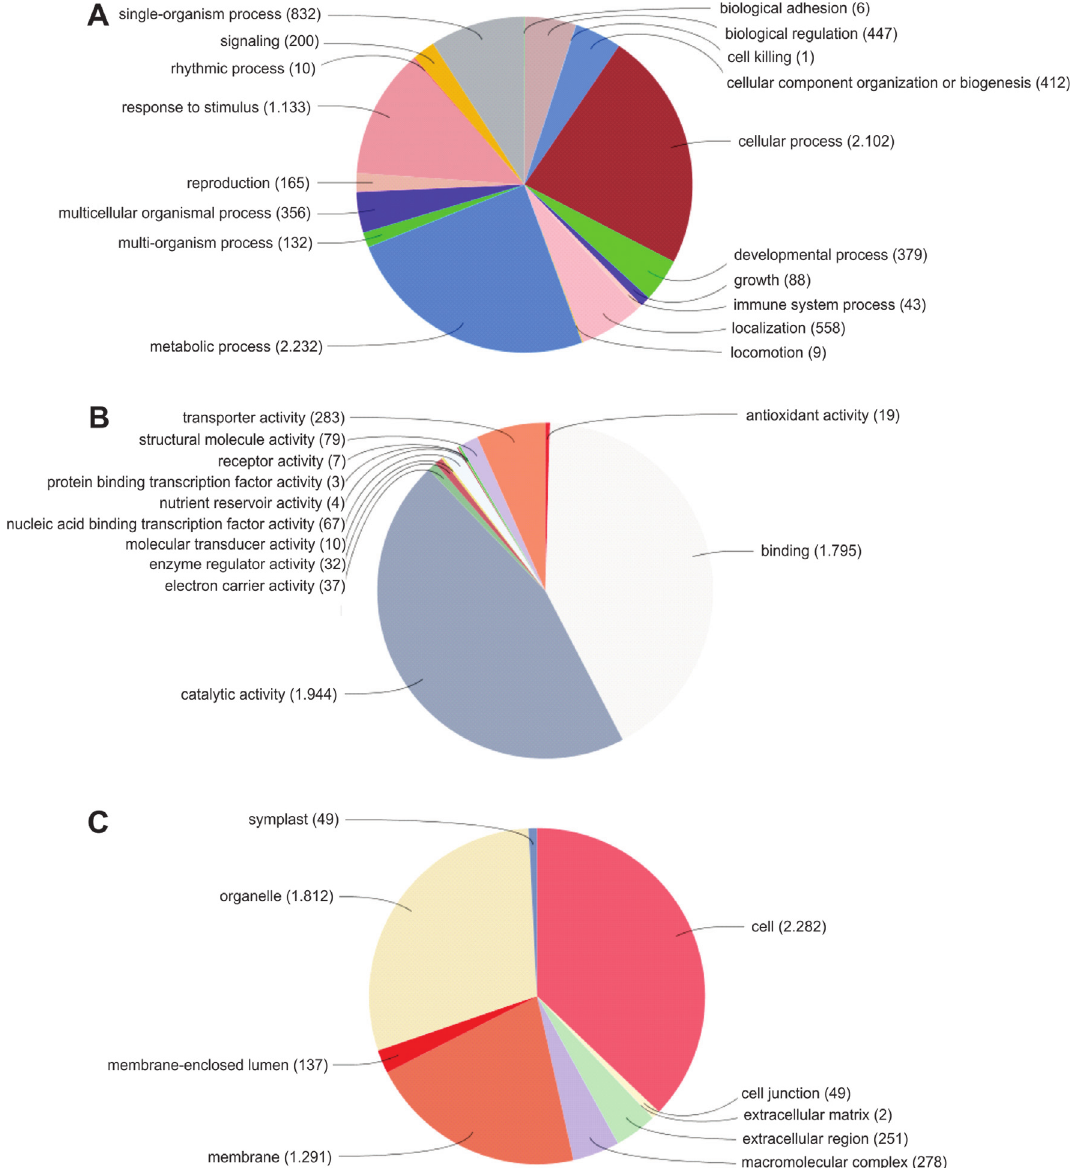
Figure 5 - Pie diagrams demonstrating the percentage of contigs and singlets generated in CAP3 within the functional categories of Gene Ontology. Re- sults are based on Blast2GO data mining. (A) Biological process, (B) molecular function, and (C) cellular